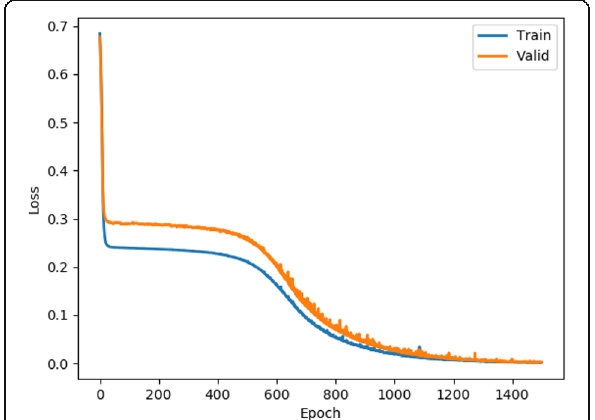
Fig. 7 Loss values during the ANN model training